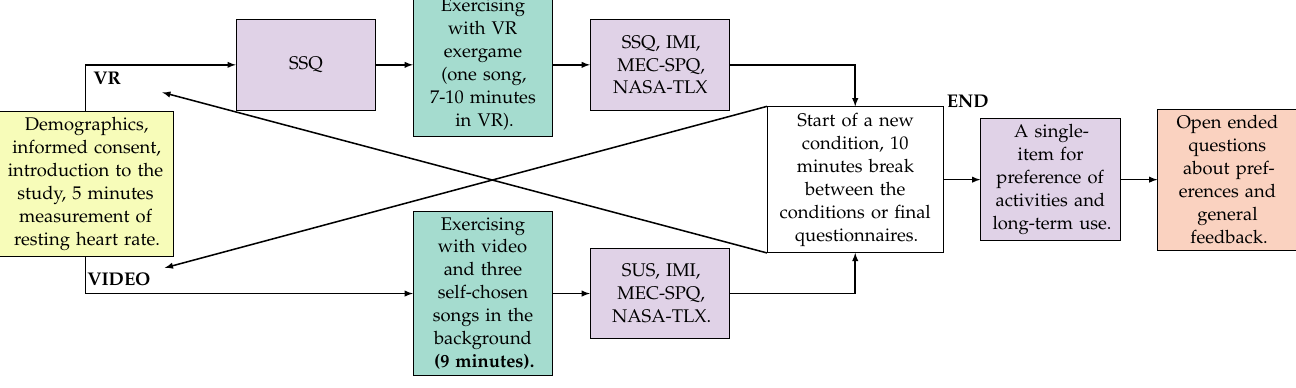
Figure 4. Procedure for the study on a comparison of a 2D gymnastics video to a VR exergame. In case of the exergame, the participants filled out a before measure of the SSQ. Then, they watched a short demonstration video of the experimenter playing the game, so